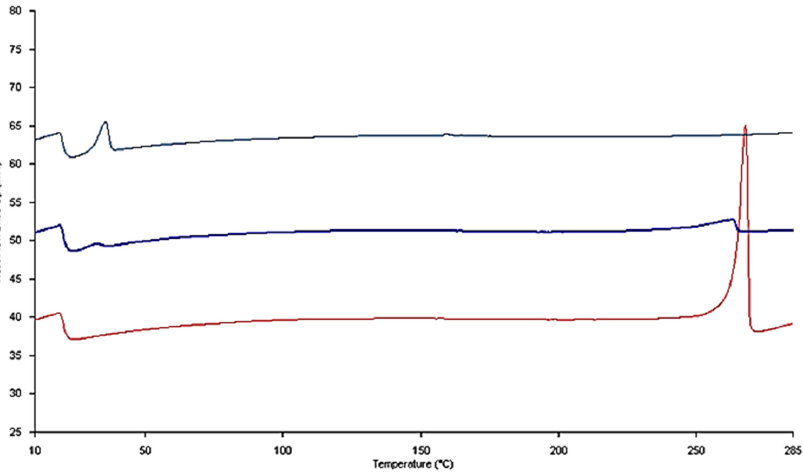
Figure 6. DSC thermograms of a selected RES-TPGS 1:4 formulation (gray line), RES:TPGS 1:4 physical mixture (blue line), and raw RES (red line).